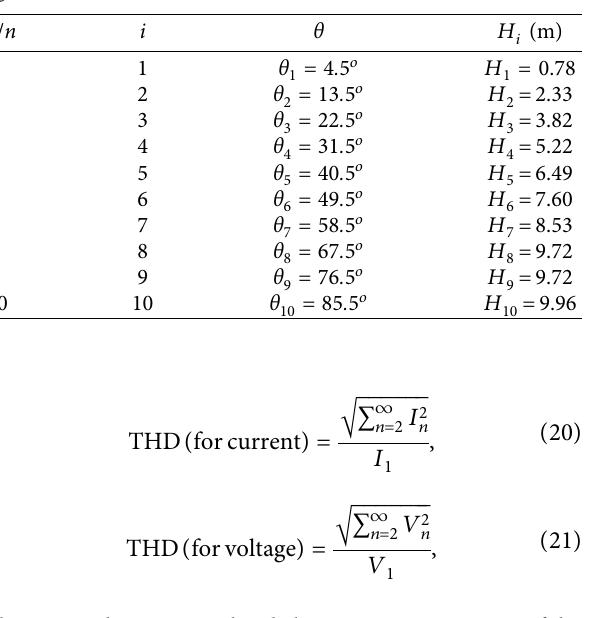
Table 2: Calculation of heights of staircase modulating reference signal from zero-axis.